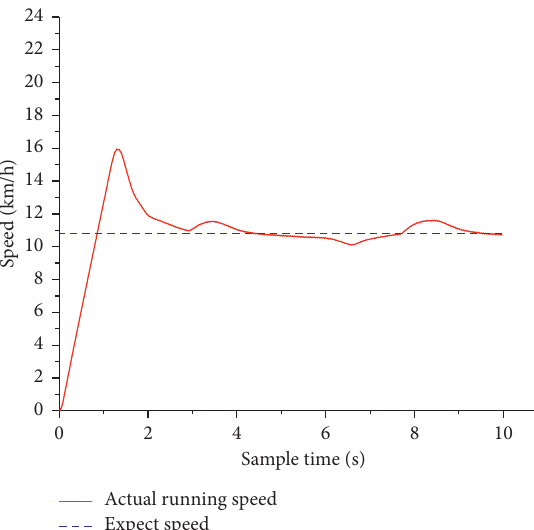
Figure 14: Curve tracking speed simulation